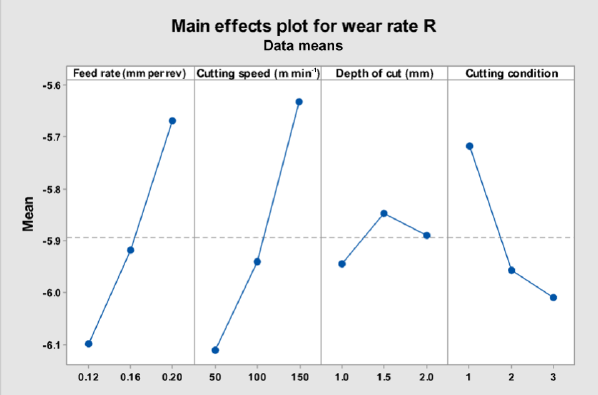
Figure 5. Relationship between cutting speed and temperature for different materials (data from Shaw,